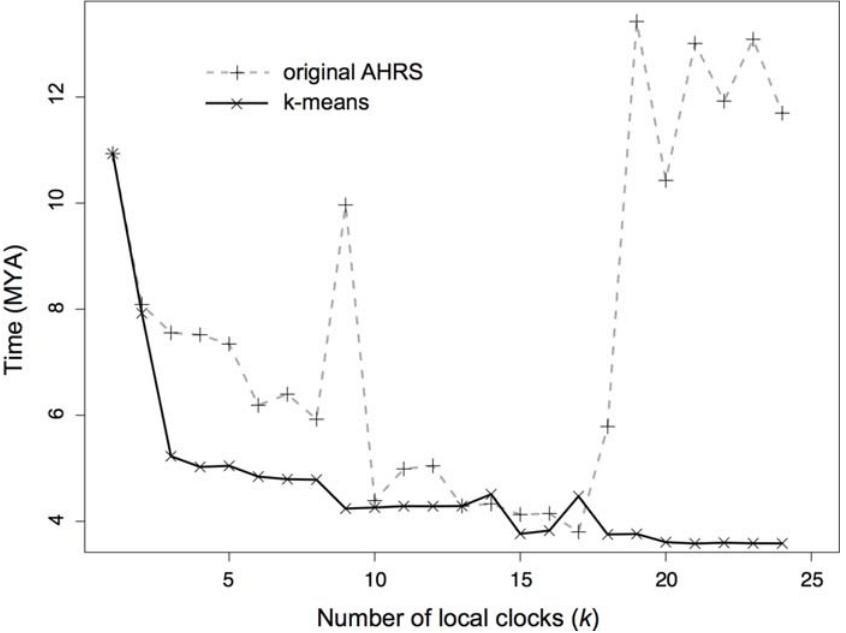
Figure 1. Effect of the number of local clocks on the age of a node far from all calibration points. Times were estimated using either the original AHRS algorithm or k-means and are given in million years ago (MYA). The focal node is the split at the origin of the mouse lemurs (genus Microcebus).